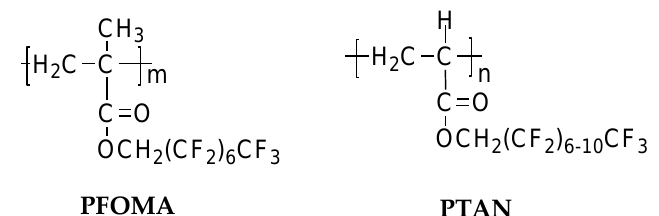
Figure 4. Chemical structure of hydrophilic poly(2-dimethylaminoethyl methacrylate) (PDMAEMA) and hydrophobic poly(1,1′-dihydroperfluorooctyl methacrylate) (PFOMA) and poly(1,1,2,2-tetrahyfoperfluorooctyl acrylate) (PTAN) [19].